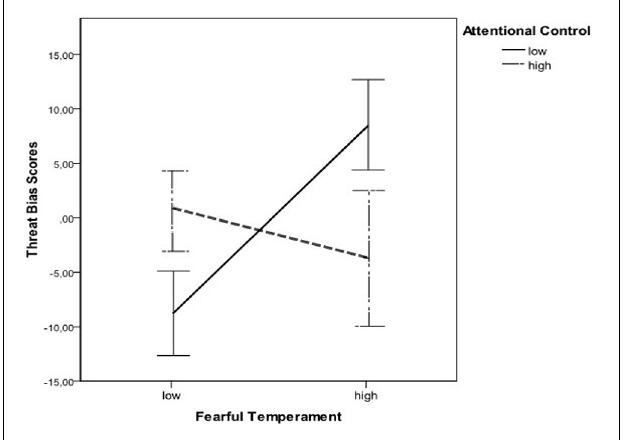
FIGURE 1 | Interaction effect of temperamental fear and temperamental attentional control on threat bias scores (bars represent values of standard